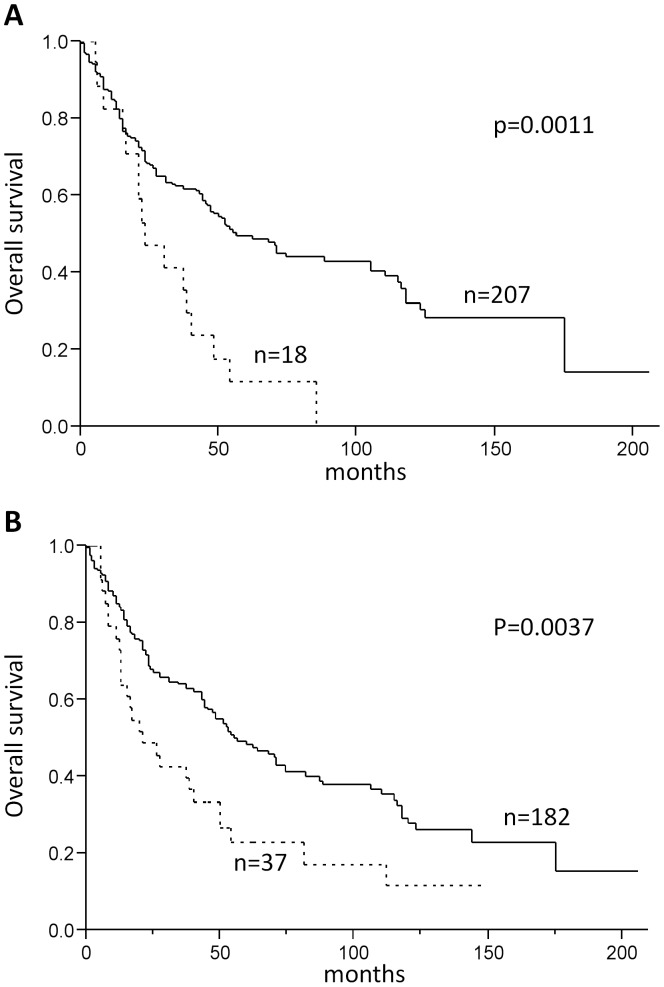
Survival analysis of patients with HNSCC.A) Kaplan-Meier curve analysis illustrating a worse overall survival for HNSCC patients with detectable Ano1 protein expression (solid line: Ano1 protein negative, dashed line: Ano1 protein positive). B) Kaplan-Meier curve analysis demonstrating a worse outcome for patients with 11q13 (Ano1) amplified HNSCC. (Solid line: normal Ano1 gene copy status, dashed line: 11q13 amplified).